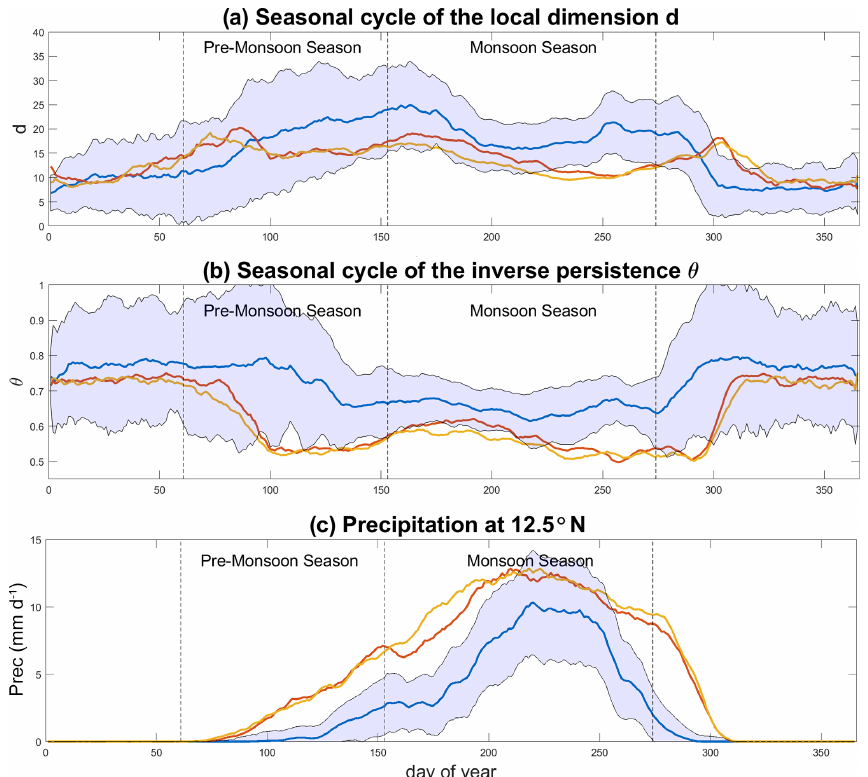
Figure 3. Seasonal cycle of median (a) d , (b) θ and (c) zonally averaged daily precipitation (mmd − 1 ) at 12.5 ◦ N for the MH CNTL (blue), MH GS+PD (red) and MH GS+RD (orange) simulations. The blue shading marks ± 1 SD from the MH CNTL . The vertical dashed lines mark the pre-monsoon (MAM) and monsoon (JJAS) seasons. The data are smoothed with a 10d moving